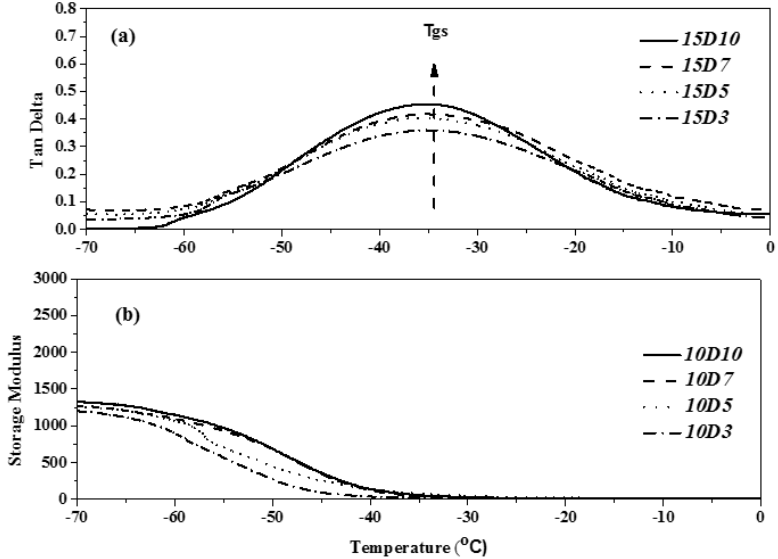
Figure 18. DMA curve of TPU with end-capping agent at concentration of 15 phm, (Effect of temperature on ( a ) Tan Delta ( b ) the storage modulus of TPU)